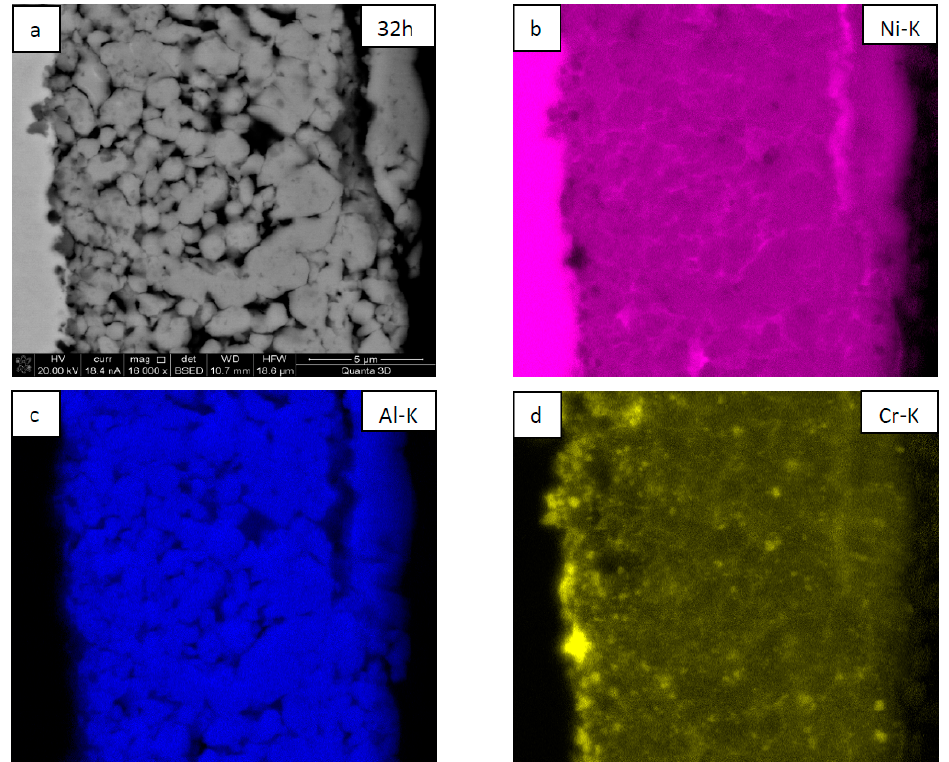
Figure 5. SEM / BSE image of NiAl + CrB 2 coatings deposited on nickel substrate after 32 h of milling ( a ) and maps presenting the distribution of nickel ( b ), aluminum ( c ), and chromium ( d